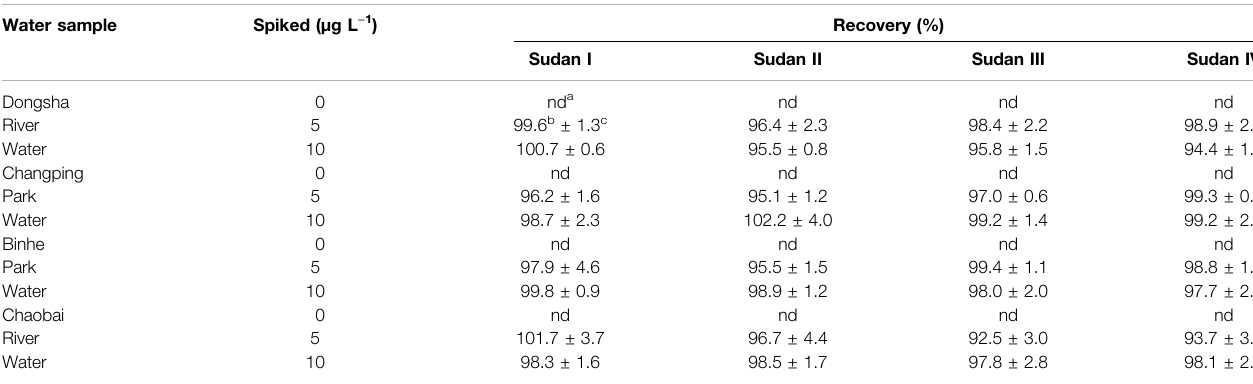
TABLE 2 | Analytical results in real water samples. Water